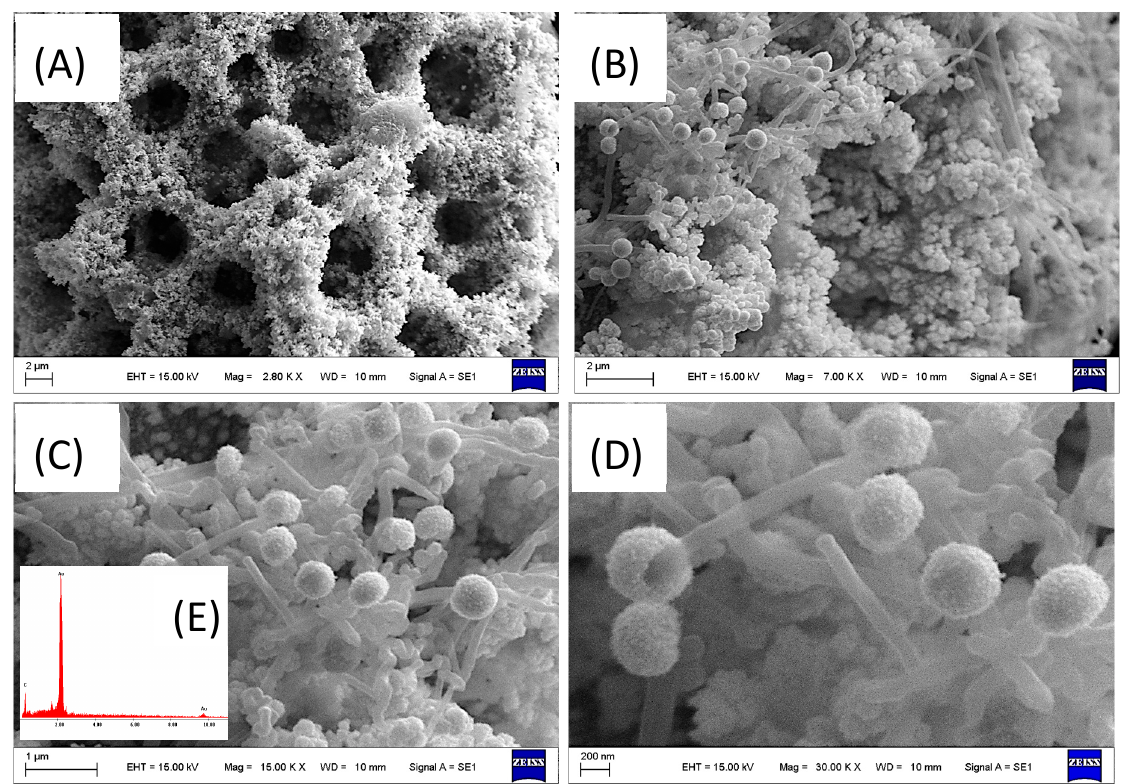
Figure 2. SEM micrographs of CNF/GNP composite at different magnifications. Inset: energy dispersive spectrum. ( A ) Uniform gold nanoporous honeycomb-like image. ( B , C ) GNP dendritic structure and the CNF interspersed in the gold by in situ co-deposition. ( D ) Electrode surface. ( E ) EDS spectrum.